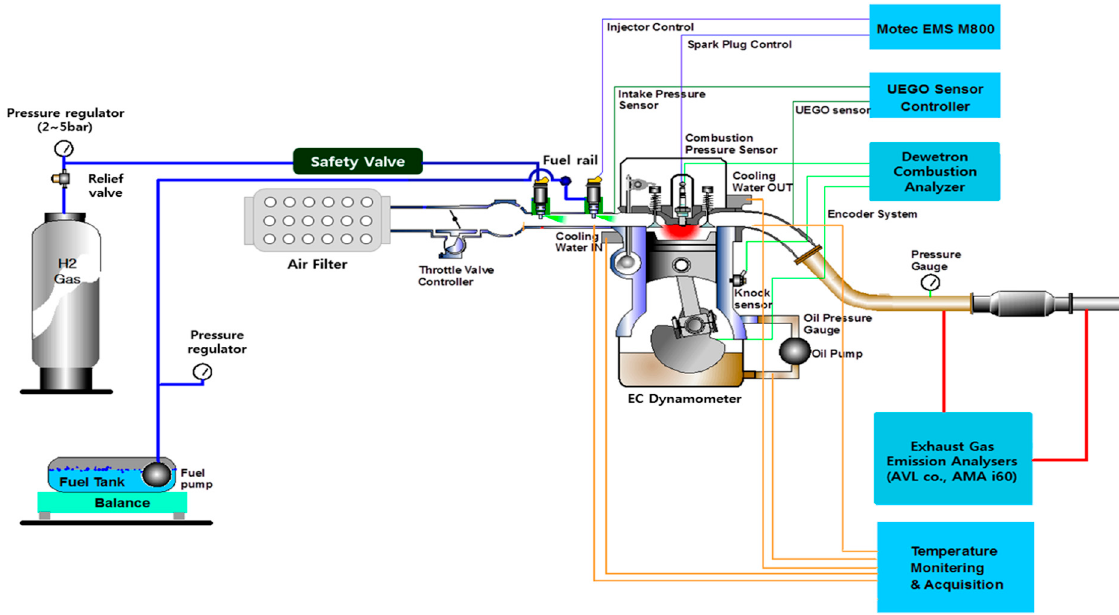
Figure 1. Schematic diagram of experimental setup.